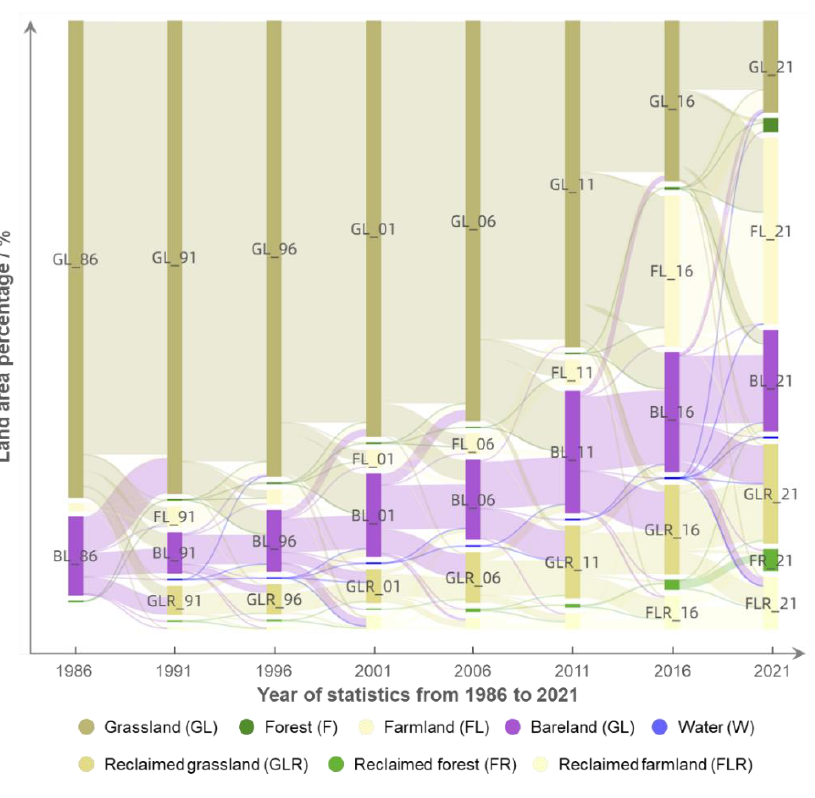
Figure 6. Land use type conversion during 1986 – 2021.